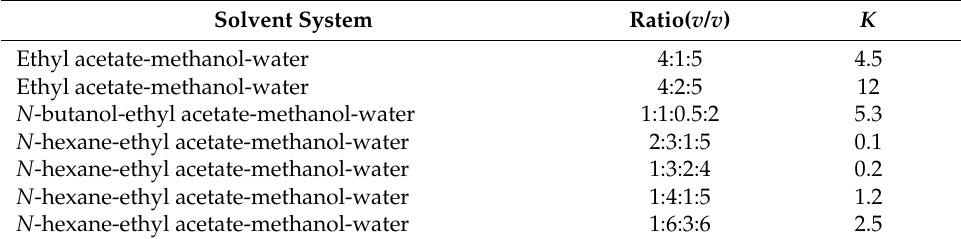
Table 1. The K values of phlorizin (PHZ) in different two-phase solvent